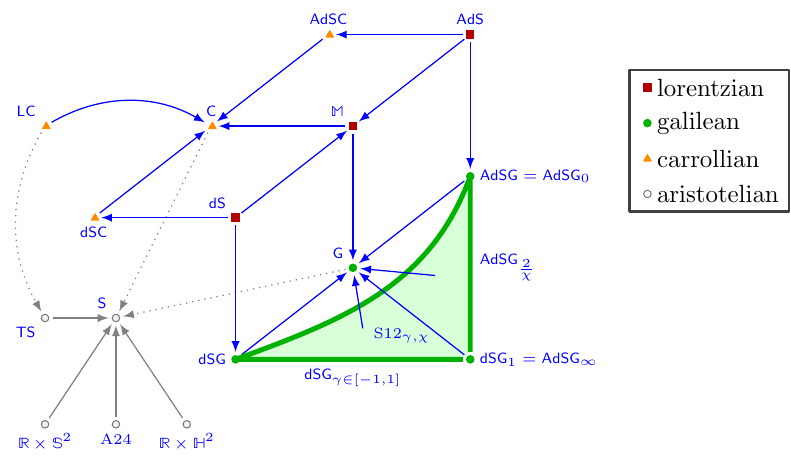
Figure 2 . Three-dimensional homogeneous spacetimes and their